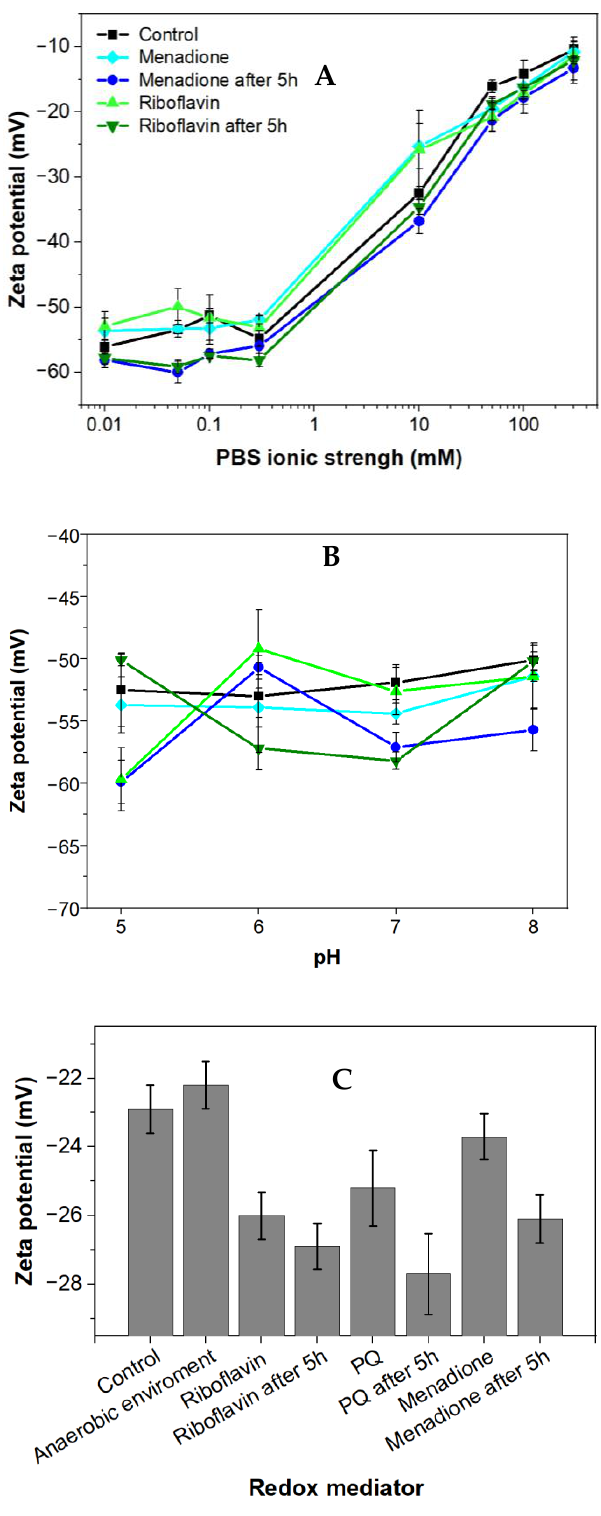
Figure 2. Zeta potential (mean ± SD) of Rhizobium anhuiense at mid-logarithmic phase: ( A ) Zeta potential as a function of ionic strength; ( B ) zeta potential measured in 0.1 mM PBS as a function of pH; and ( C ) zeta potential values in growing Norris medium at pH 7.0. Measurements were performed in PBS at pH 7.0 in the presence of several redox mediators (5 mM of menadione, 0.2 μM of riboflavin, and 4 mM of 9,10-phenanthrenequinone), and under anaerobic conditions.